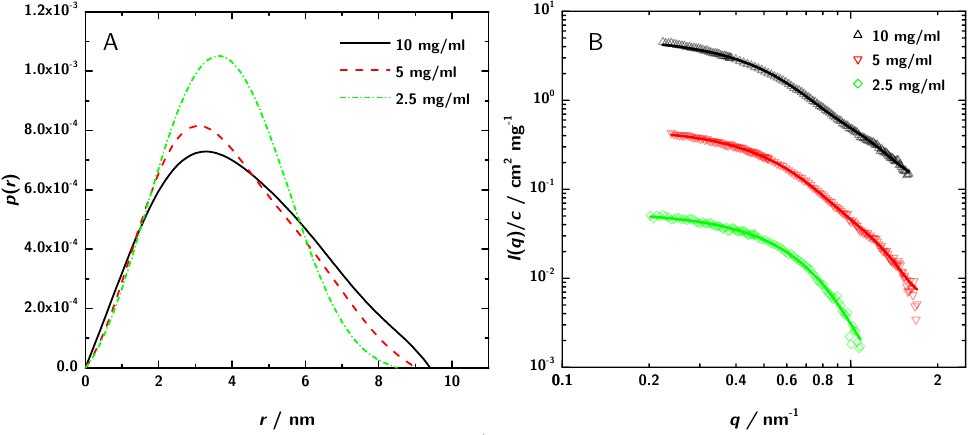
Figure 4. ( A ) p ( r ) —functions obtained by GNOM and ( B ) the corresponding fit in the reciprocal space (for clarity, the upper two data sets have been shifted by a factor of 10 and 100,